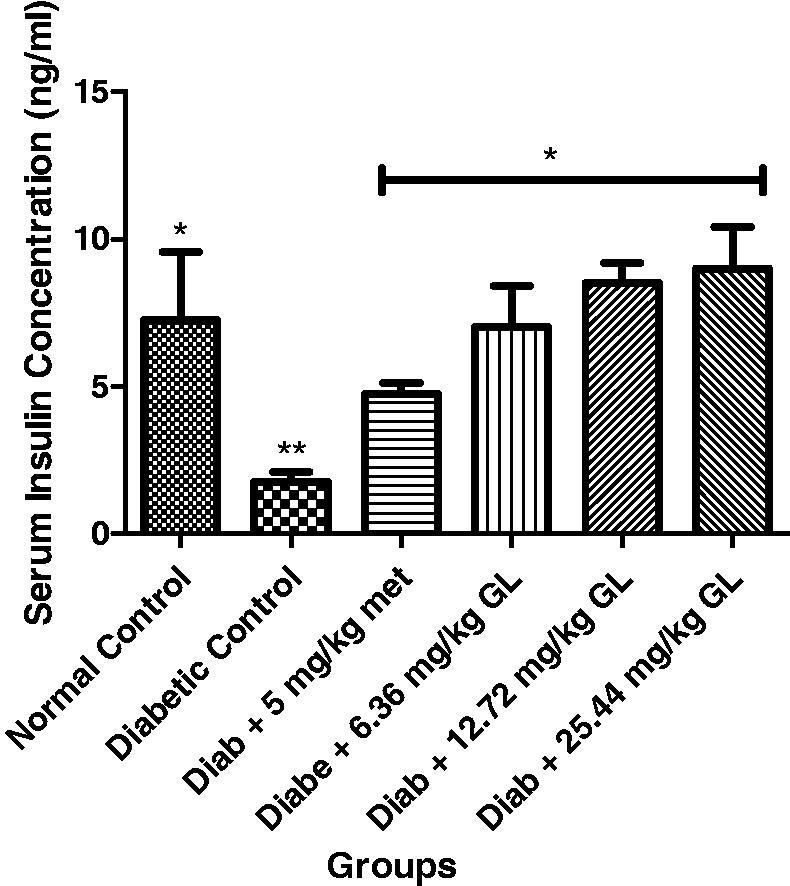
Serum insulin level of alloxan-induced diabetic rats after administration of G. latifolium leaf. Values are expressed as mean ± standard deviation (SD) of eight replicates. Bar with the same * are not significantly different at p > 0.05. Bar with different * are significantly different at p < 0.05. Normal control: non-diabetic control; GL: Gongronema latifolium leaf; Diab: diabetic; met: metformin.